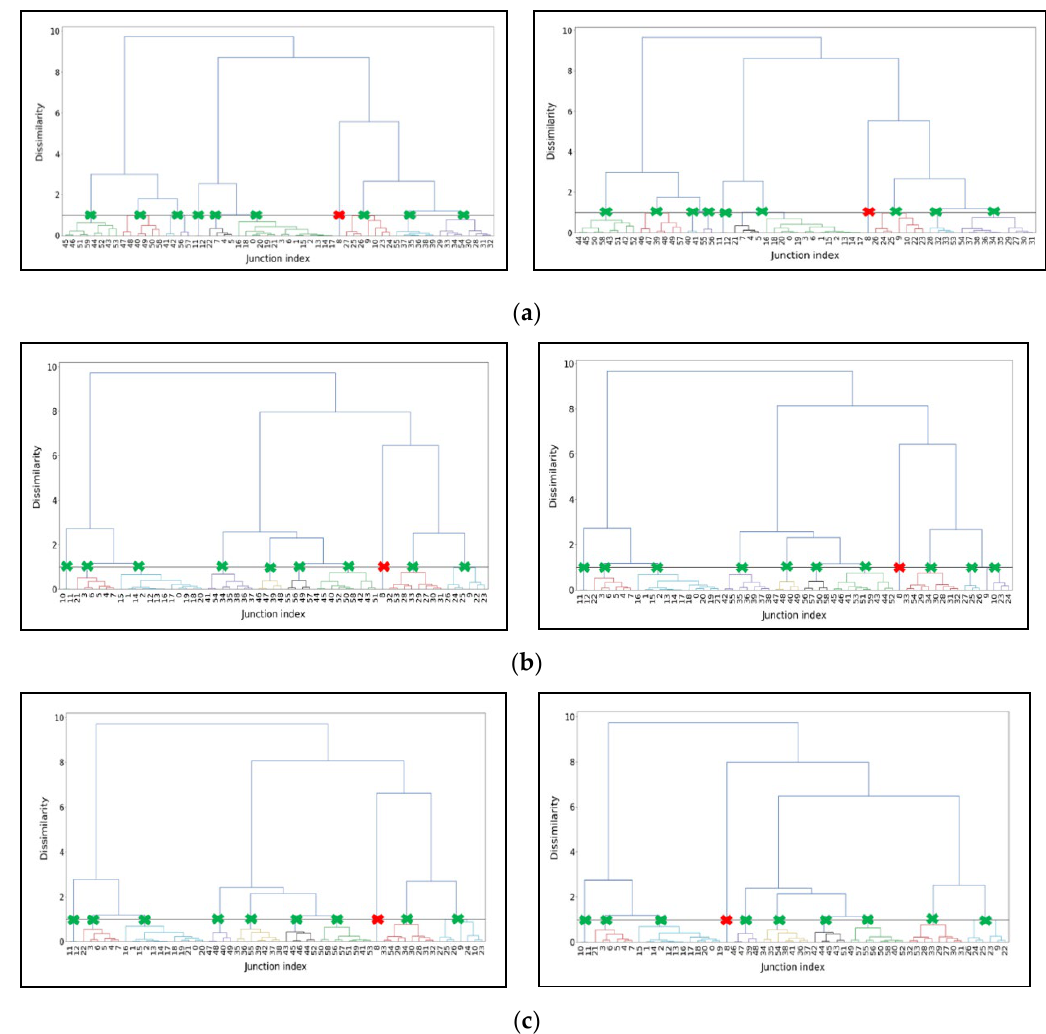
Figure 9. Dendrogram (green X representing acceptable cluster; red X representing unacceptable cluster) for comparing agglomerative cluster numbers between 2-year return period (the left subplots) and 5-year return period (the right subplots) rainfall scenarios. ( a ): left 2 year-3 h; right 5 year-3 h; ( b ): left 2 year-12 h; right 5 year-12 h; ( c ): left 2 year-48 h; right 5 year-48 h.